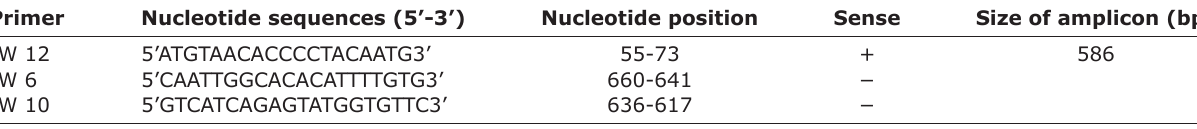
Table-1: Primers used for HnRT-PCR to target N gene. Primer Nucleotide sequences (5’-3’)